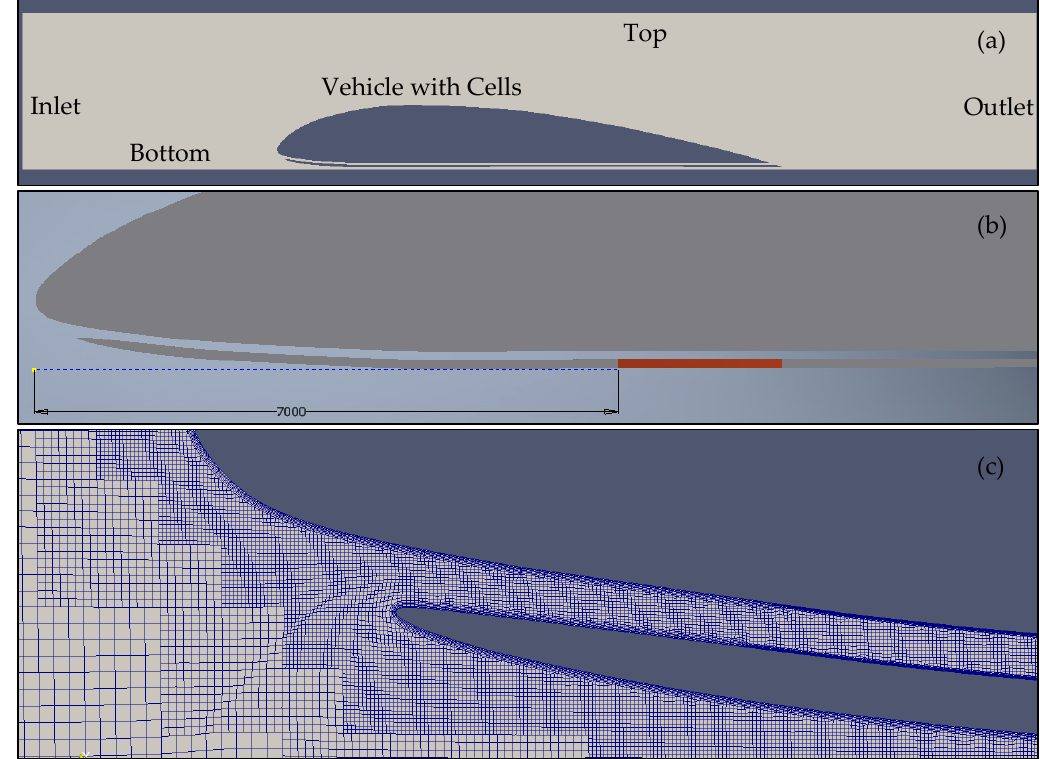
Figure 2. Numerical domain for the vehicle with batteries and heat transfer calculations: ( a ) numerical geometry and boundary conditions, ( b ) position of the batteries in the vehicle (red), ( c ) detail of the numerical mesh in the vicinity of the cooling ducts (the inner duct and the duct below the tunnel).